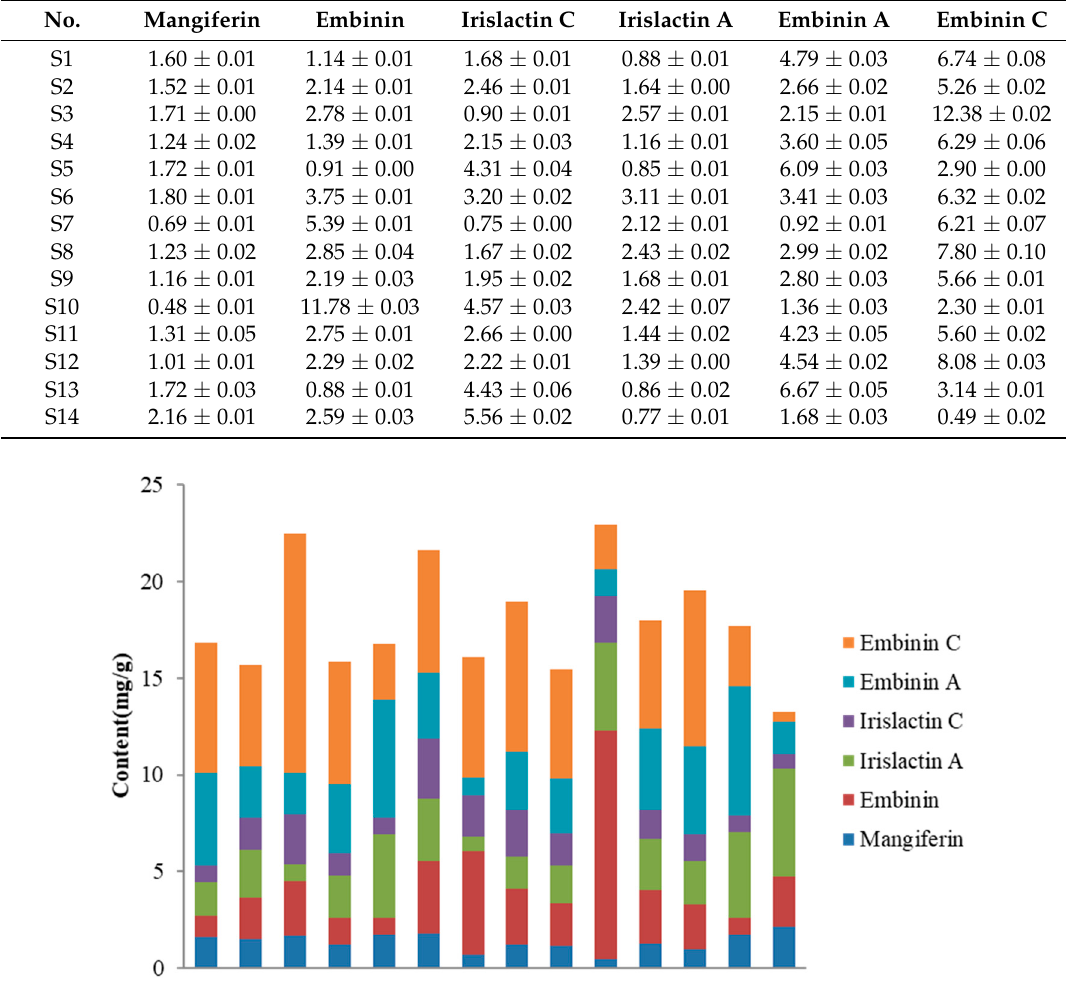
Table 3. Contents of six components in I. lactea leaves from different regions (Mean ± SD, mg/g, n = 3). No. Mangiferin